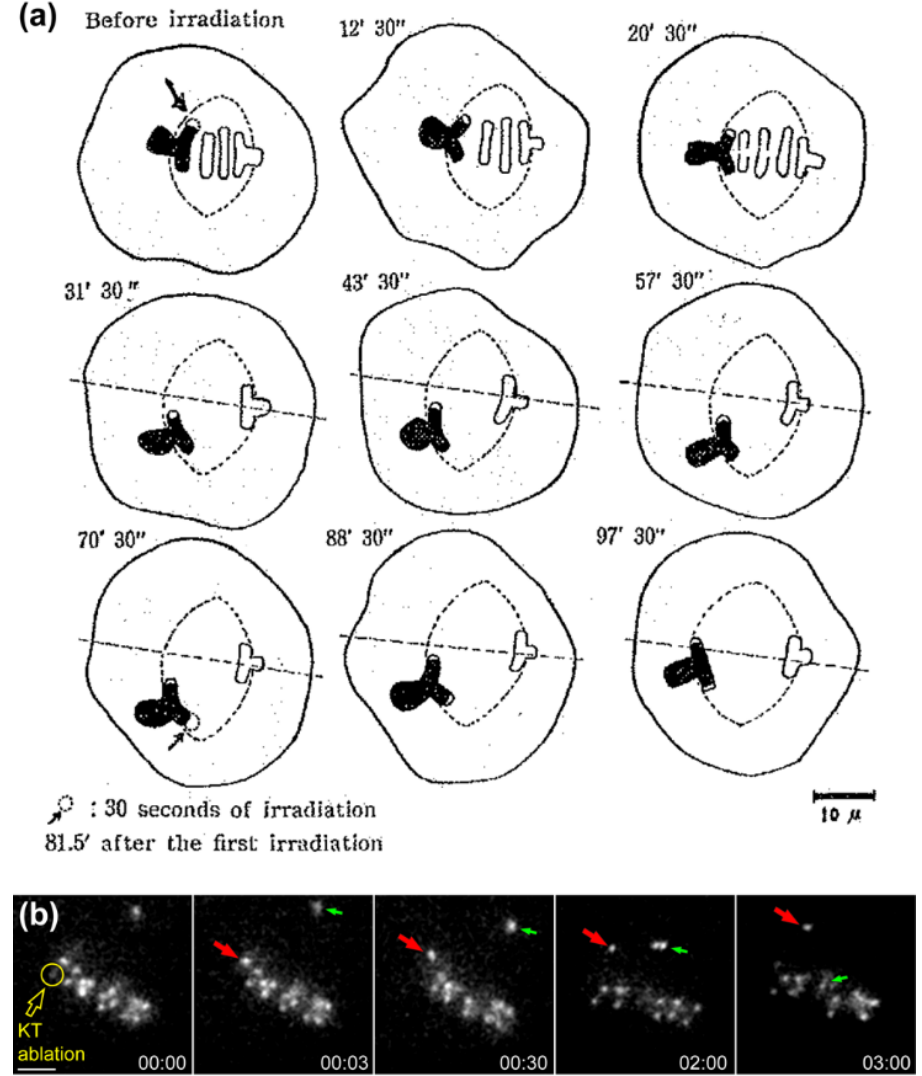
Figure 2. Evidence that forces on kinetochores are required to position chromosomes at the equator. ( a ) Original drawings from Izutzu depicting the loss of equatorial position when one of the kinetochore regions from a bivalent chromosome was irradiated with an UV microbeam. Note the displacement of the bivalent from the metaphase plate towards the pole facing the non-irradiated kinetochore after irradiation. Scale bar is 10 μm. Reprinted from Izutsu et al., 1959 [20]; ( b ) Laser microsurgery of one of the kinetochores from an equatorially-aligned chromosome in a Drosophila S2 cell. Kinetochores were directly labelled with the Centromere Protein A (CENP-A) homologue Cid fused with Green Fluorescent Protein (GFP). Likewise, the chromosome was displaced from the equator after surgery and underwent poleward migration towards the pole facing the undisturbed kinetochore from the pair. Red arrows track the undisturbed kinetochore from the irradiated pair. Green arrows track the congression of an undisturbed chromosome. Laser microsurgery was performed as described in [29]. Scale bar is 2 μm.